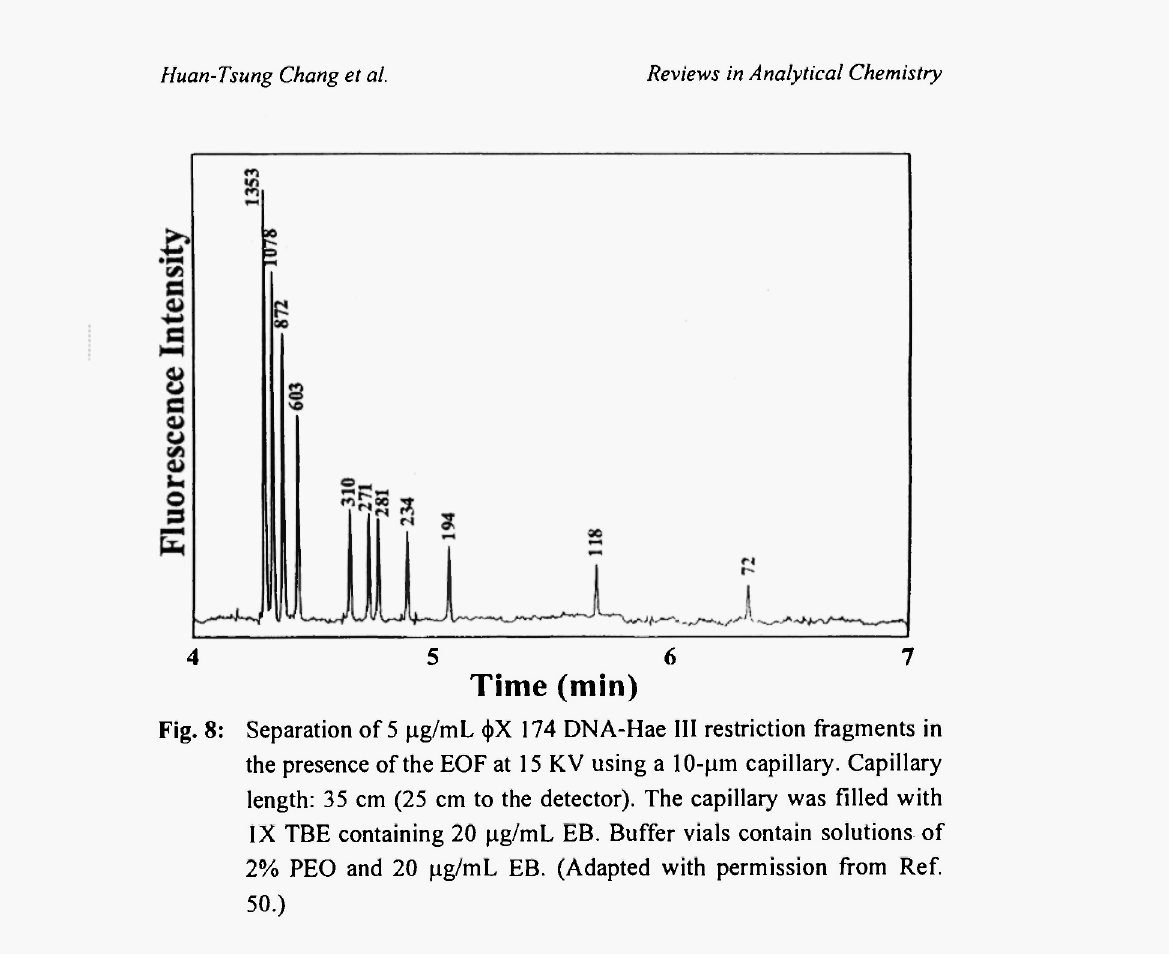
Fig. 8: Separation of 5 μg/mL φΧ 174 DNA-Hae III restriction fragments in the presence of the EOF at 15 KV using a ΙΟ-μιτι capillary. Capillary length: 35 cm (25 cm to the detector). The capillary was filled with IX TBE containing 20 μg/mL EB. Buffer vials contain solutions of 2% PEO and 20 μg/mL EB. (Adapted with permission from Ref.